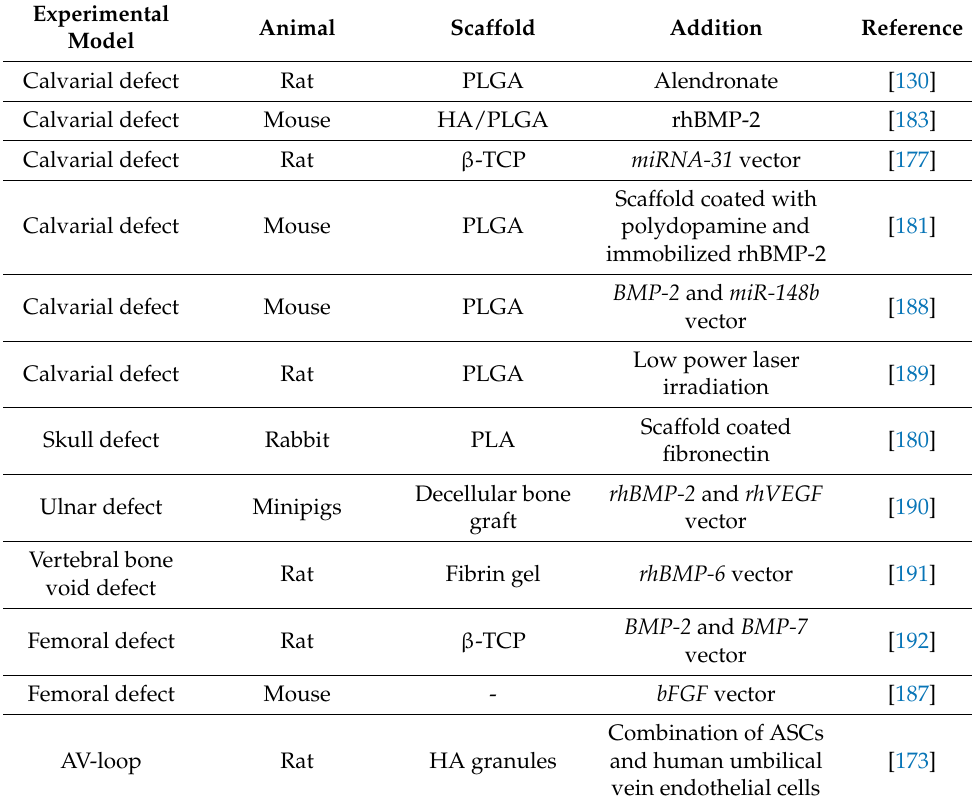
Table 1. Preclinical studies of ASCs as tool for bone tissue